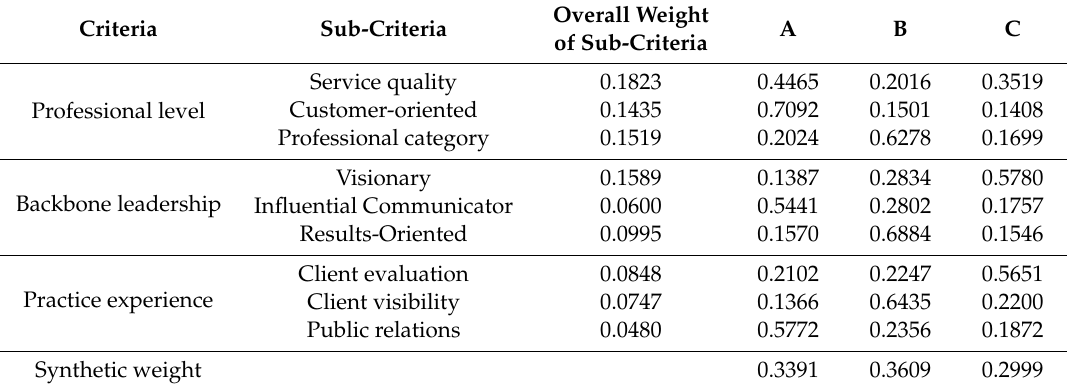
Table 9. Overall hierarchy